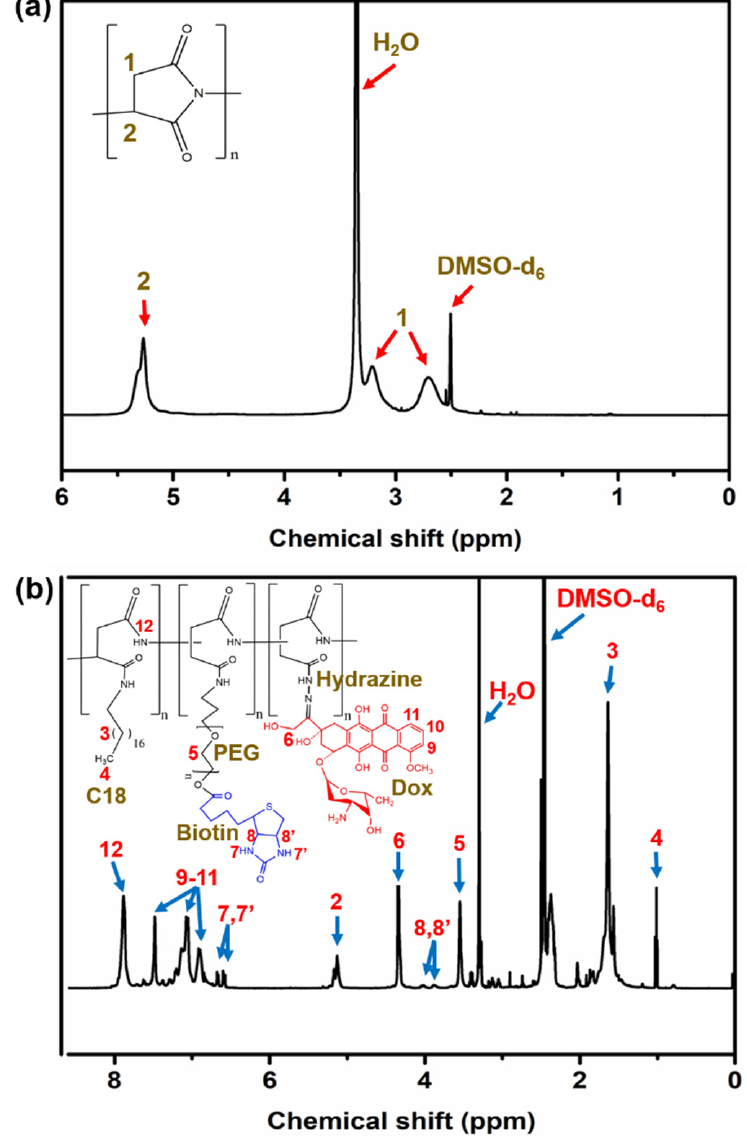
Figure 1. 1 H NMR spectra of ( a ) PSI and ( b ) PA.